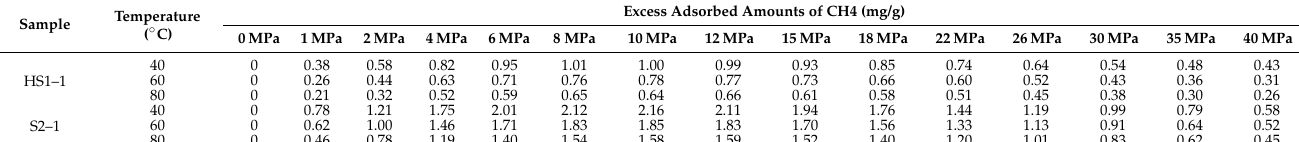
Table 3. Measured excess adsorbed amounts of CH 4 at different temperatures and pressures.